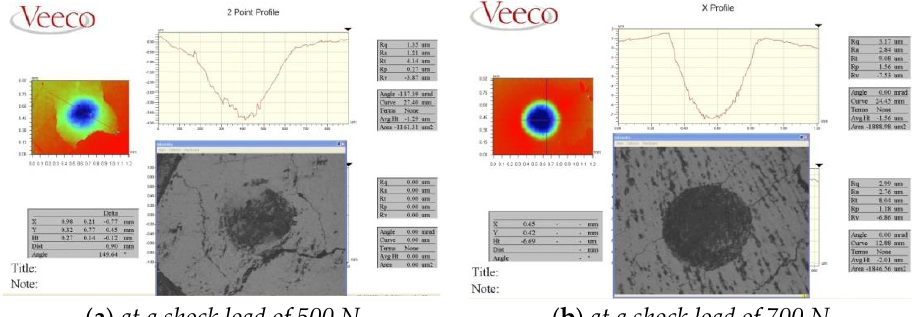
Figure 13. Cracking and peeling of the sample 2 surface.